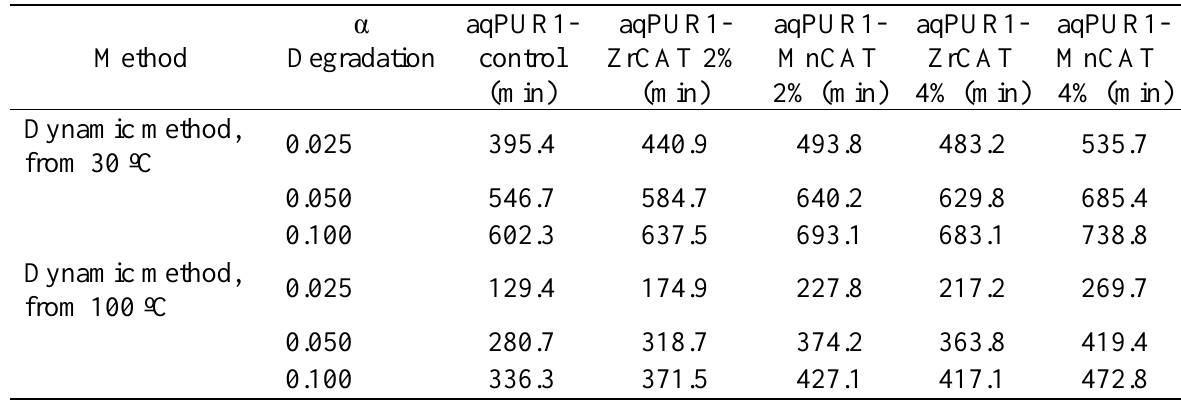
Table 5. The total time of the decomposition required to calculate the thermal stability of the sample aqPUR1 at various degrees of the degradation.